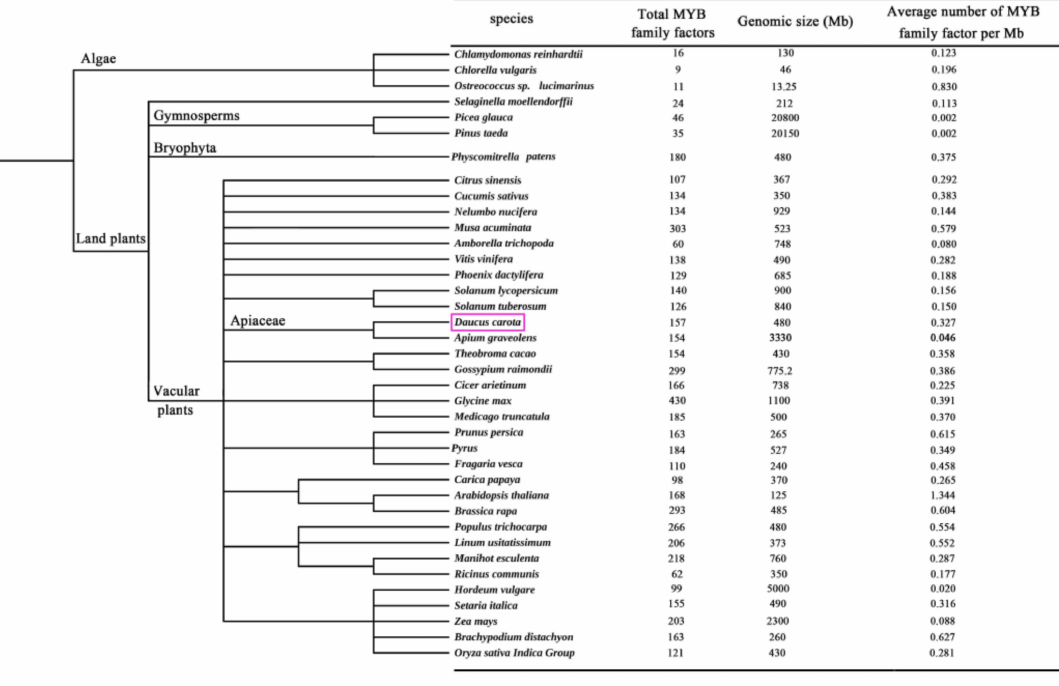
Figure 1. Summary of MYB TFs among plants. Daucus carota was highlighted with purple